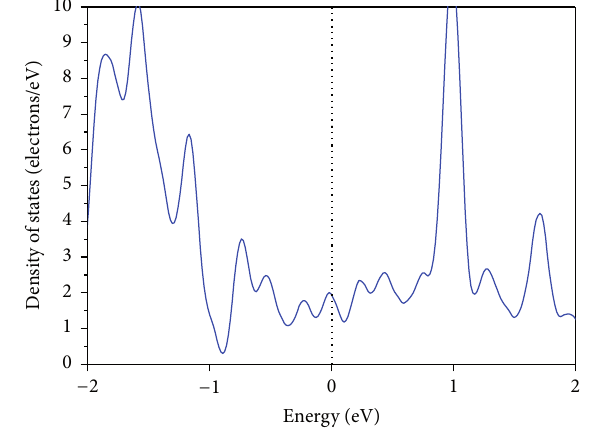
Figure 4: Density of states (DOS) of N1-doped single walled arm- chair (3,3) boron nanotube. The Fermi energy is set corresponding to zero energy and represented by dotted line.